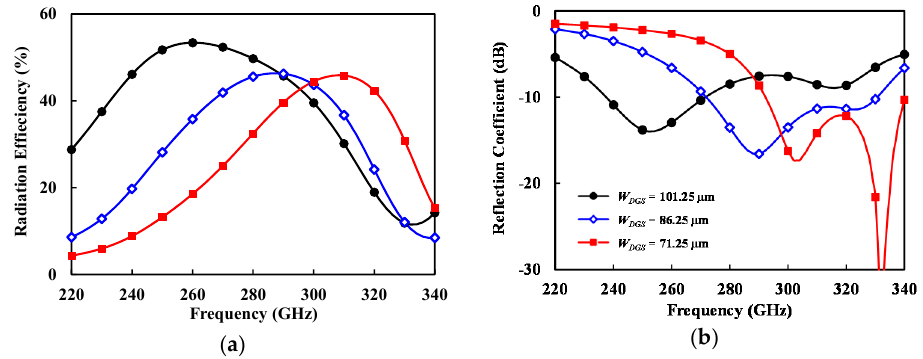
Figure 6. Simulation results of the V-shaped patch antenna with DGS depending on the slot width (W DGS ). ( a ) Efficiency. ( b ) Reflection coefficient (| S 11 |). Table 1. Design parameters of the proposed on-chip antenna.